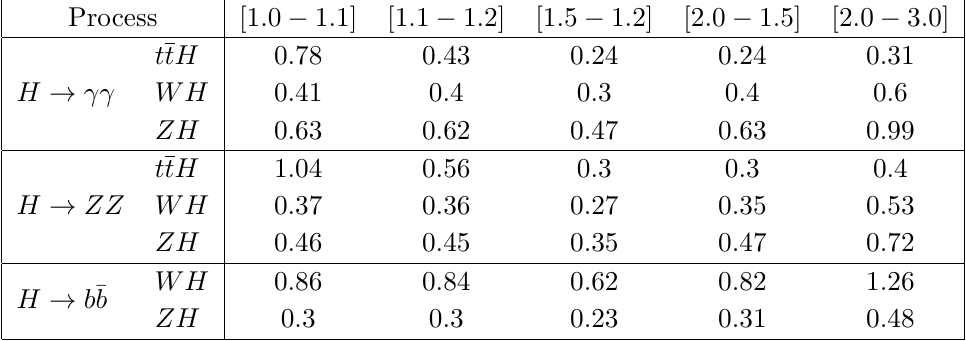
Table 8 . Estimated relative uncertainties on the determination of the di(cid:11)erential distributions in the associated Higgs production channels. These estimates correspond to the ‘pessimistic’ scenario in which the total (statistical plus systematic) uncertainty is rescaled according to the number of events in each